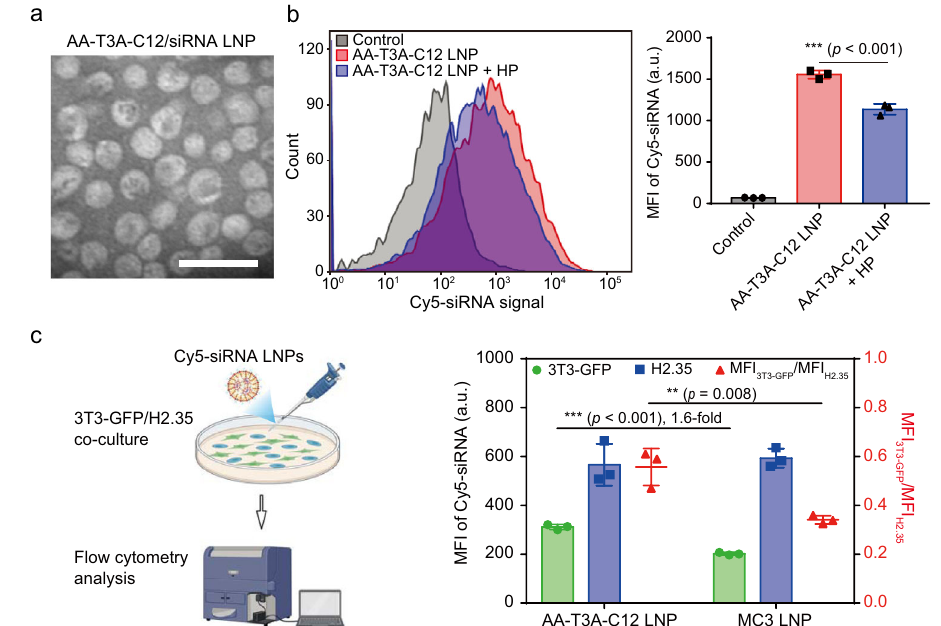
Fig. 3 | Characterization of AA-T3A-C12 LNP and cellular uptake. a A repre- sentative TEM image of AA-T3A-C12/siRNA LNP from three independent experi- ments. Scale bar, 100nm. b Flow cytometry analysis of cellular uptake of Cy5- siRNA-loaded LNPs with or without haloperidol (HP) pretreatment (representative datasetfrom n =3/group). c Flowcytometryanalysisofcompetitivecellularuptake of Cy5-siRNA-loaded LNPs in a fi broblast/hepatocyte (3T3-GFP/H2.35) co-culture